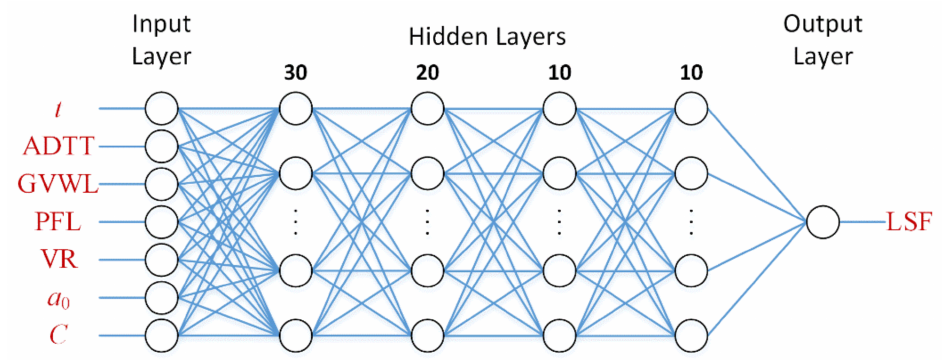
Figure 10. Architecture of the